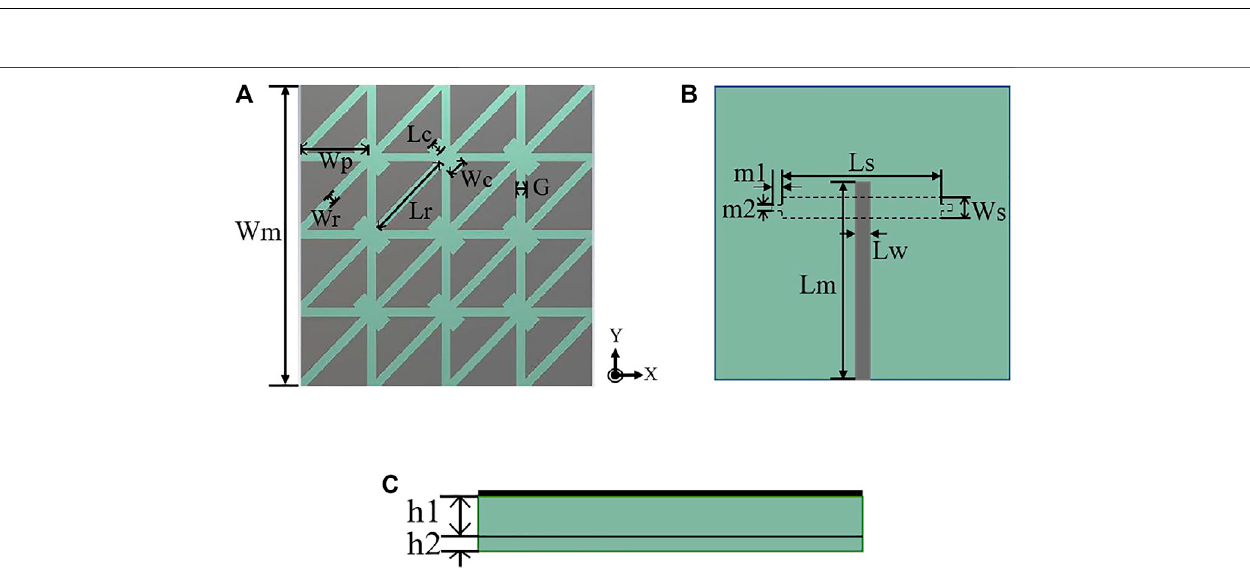
FIGURE 7 | The overall structure of the CP metasurface antenna: (A) Top view; (B) Back view; (C) Side view.